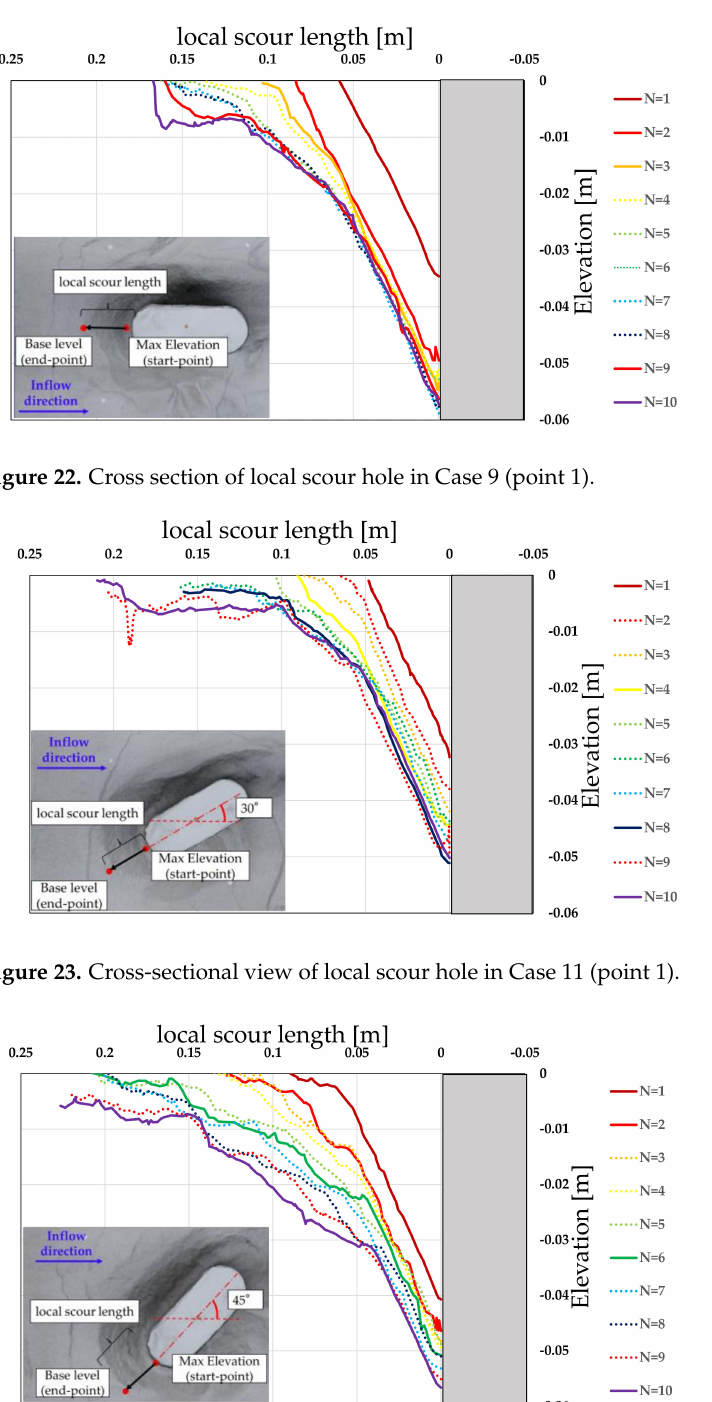
Figure 24. Cross-sectional view of a local scour hole in Case 13 (point